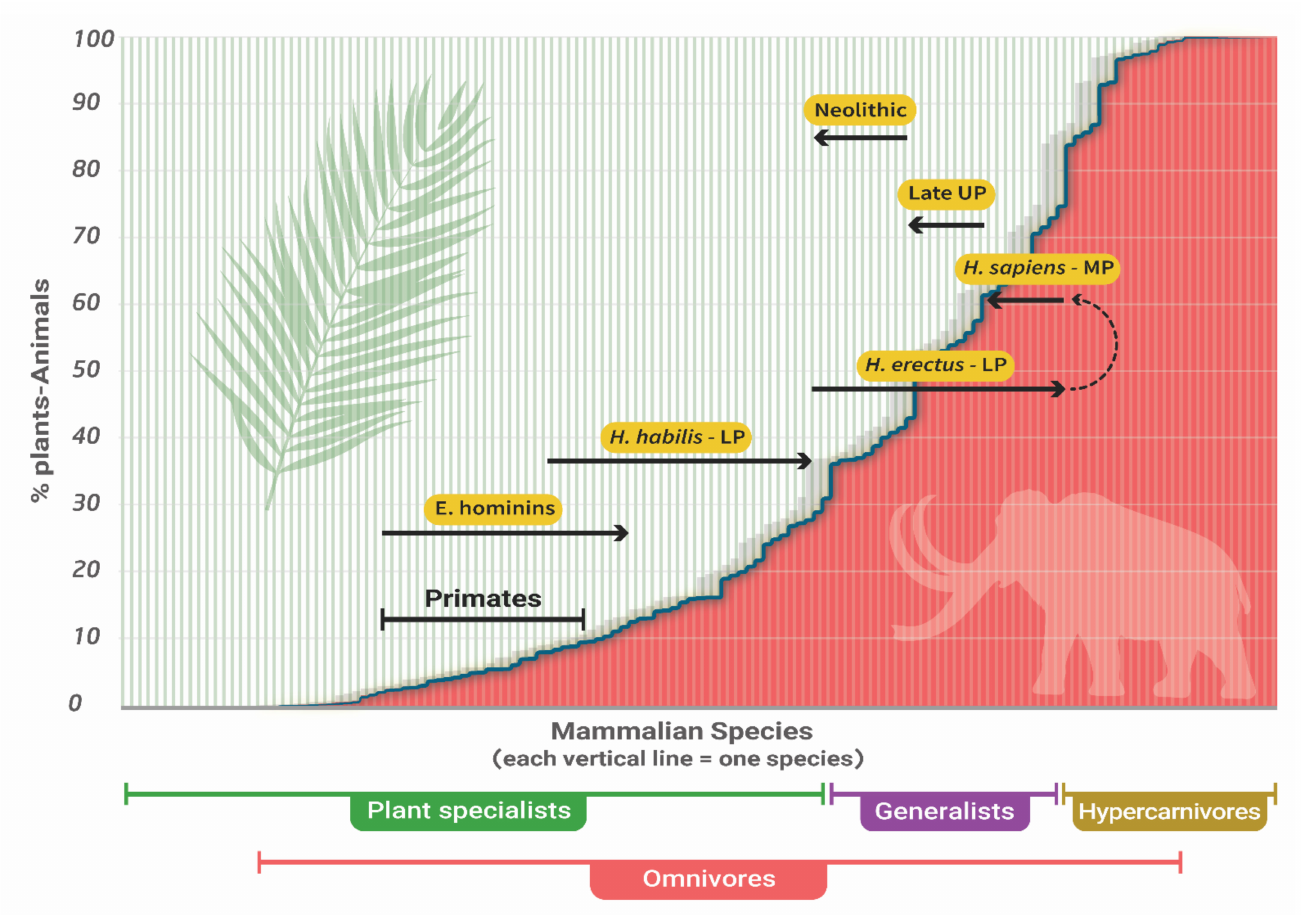
Figure 2. Proposed evolution of the human trophic level during the Pleistocene. LP–Lower Paleolithic; MP–Middle Paleolithic; UP–Upper Paleolithic; E. hominins–Early hominins, (Australopithecus, Paranthropus). Background and position of primates adapted from [23]. Each line corresponds to the plants and animals’ food-source ratio of one mammalian species. Plant specialists and hypercarnivores–mammals that obtain over 70% of their food from plants and animals, respectively. Omnivores–any mammal that obtains food from both plants and